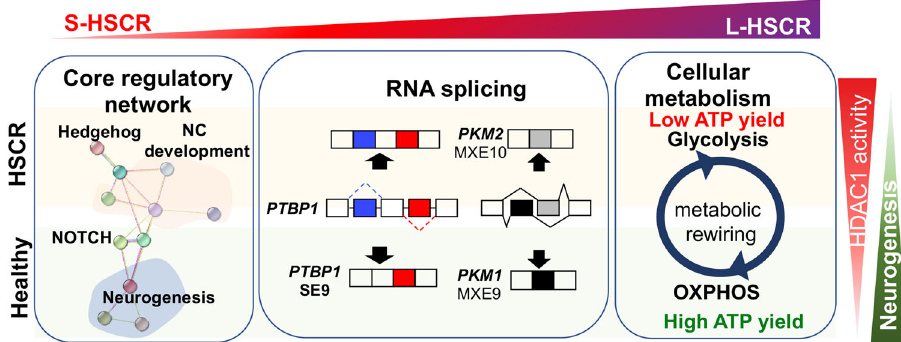
Fig. 8 | Schematic summaries of the key molecular and cellular processes associatedwithHSCRpathogenesisandseverity. Acoregenesetassociatedwith the severity of HSCR was identi fi ed. Additional alternations in genes implicated in